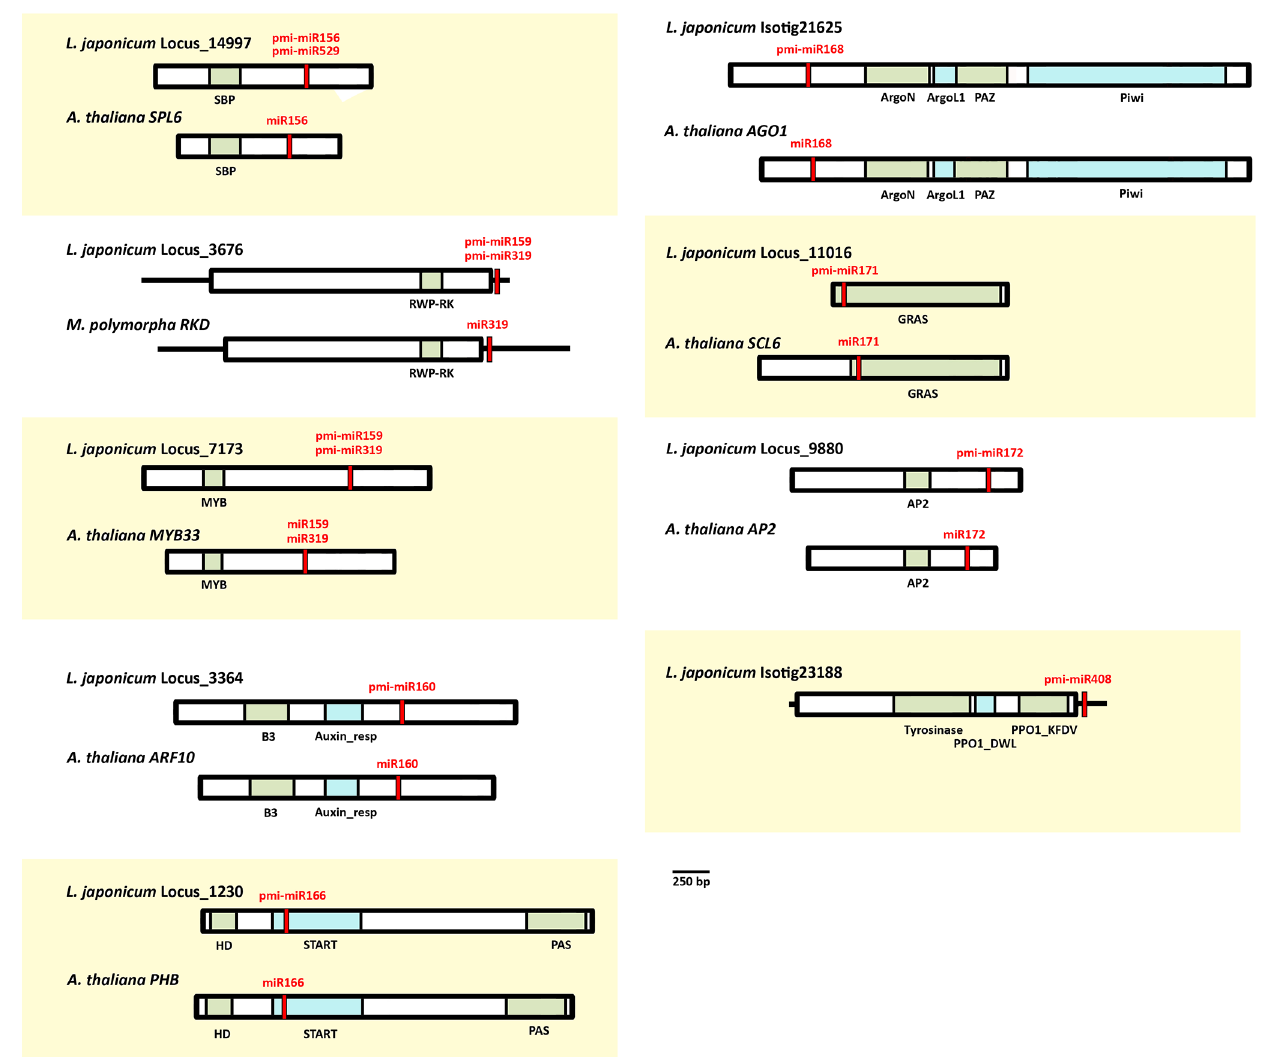
Fig 4. Conserved targets of fern miRNAs. Schematicrepresentations of L . japonicum mRNAs predictedto be targeted by P . minima miRNAs. For comparison, homologous mRNAs and miRNAs from other land plants ( A . thaliana or M . polymorpha ) are also shown. Codingregions are shown as rectangles and UTR regions as thick black lines. Protein domainswithin coding regionsare coloured. Regionspredictedto be targeted by pmi-miRNAs are indicatedby red stripes. Note that the positionsof miRNA-targeted regions in mRNAs are conservedbetween L . japonicum and other plants. For pmi-miR408the sequencefor the homologous PPO mRNA from P . endiviifolia is not available and is not shown.